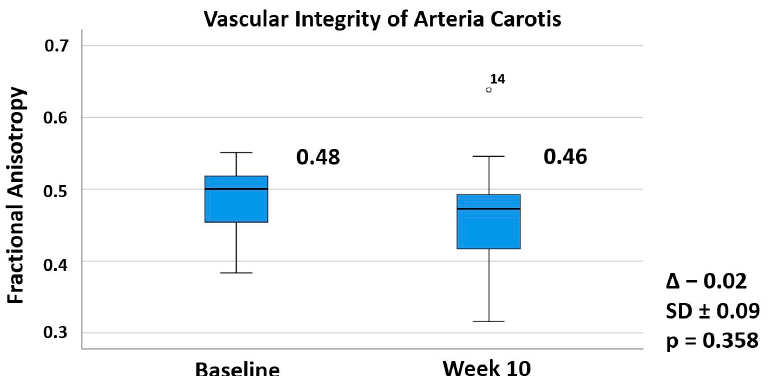
Figure 1. Effects of Alirocumab on a Novel Magnetic Resonance-based Vascular Parameter. Legend: Assessment of vascular integrity by evaluating fractional anisotropy of the carotid vessel wall. The numerical data shows mean values at baseline and week 10 of alirocumab treatment with mean change, standard deviation, and p -value, while boxplots graphically represent medians and inter- quartiles. The small circle with the number 14 at the right upper side of the figure identifies an outlier measurement of patient number 14 at week 10. Outliers are defined as values between 1.5x and 3x interquartile ranges from the end of a box. Fractional anisotropy is a scalar value without a unit between one and zero. Lower values of fractional anisotropy are considered to reflect patho- logical changes of the carotid vessel wall structure. Trial-completion analysis of patients with two valid assessments for statistical analysis (n = 13). Paired t-test with a two-sided p -value.